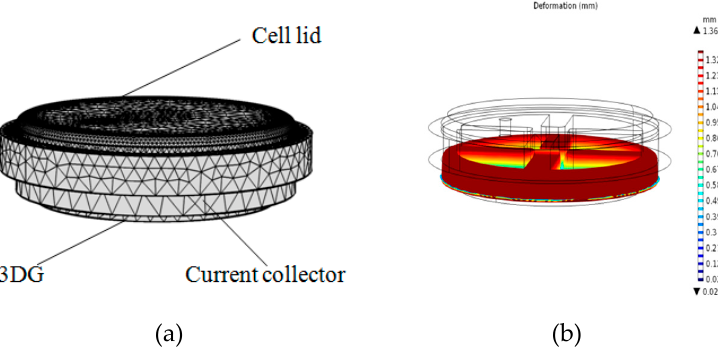
Figure 8. ( a ) The calculation model; ( b ) the deformation of support current collector